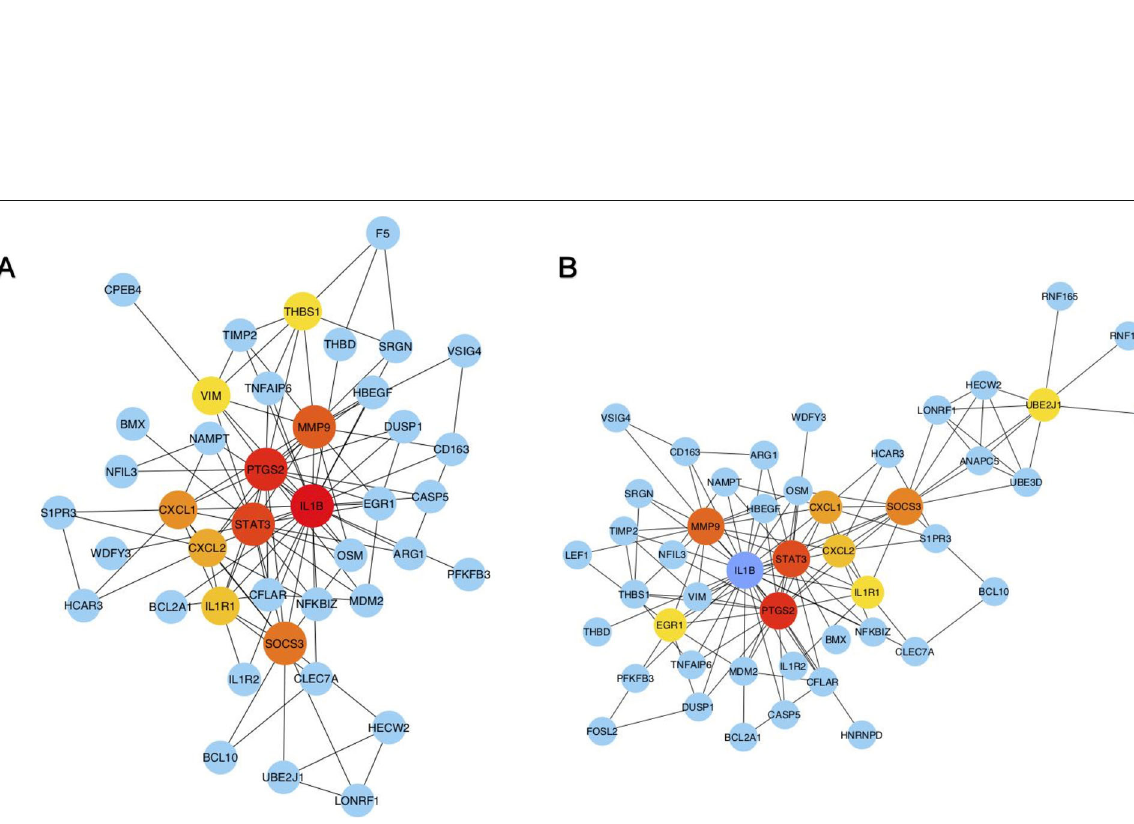
Fig. 7 PPI networks. (A) PPI network of upregulated DE-mRNAs. (B) PPI network of all DE-mRNAs. The size and color of the map nodes are determined by the degree value; a small size with a low degree is shown in blue, and a large size with a high degree is shown in